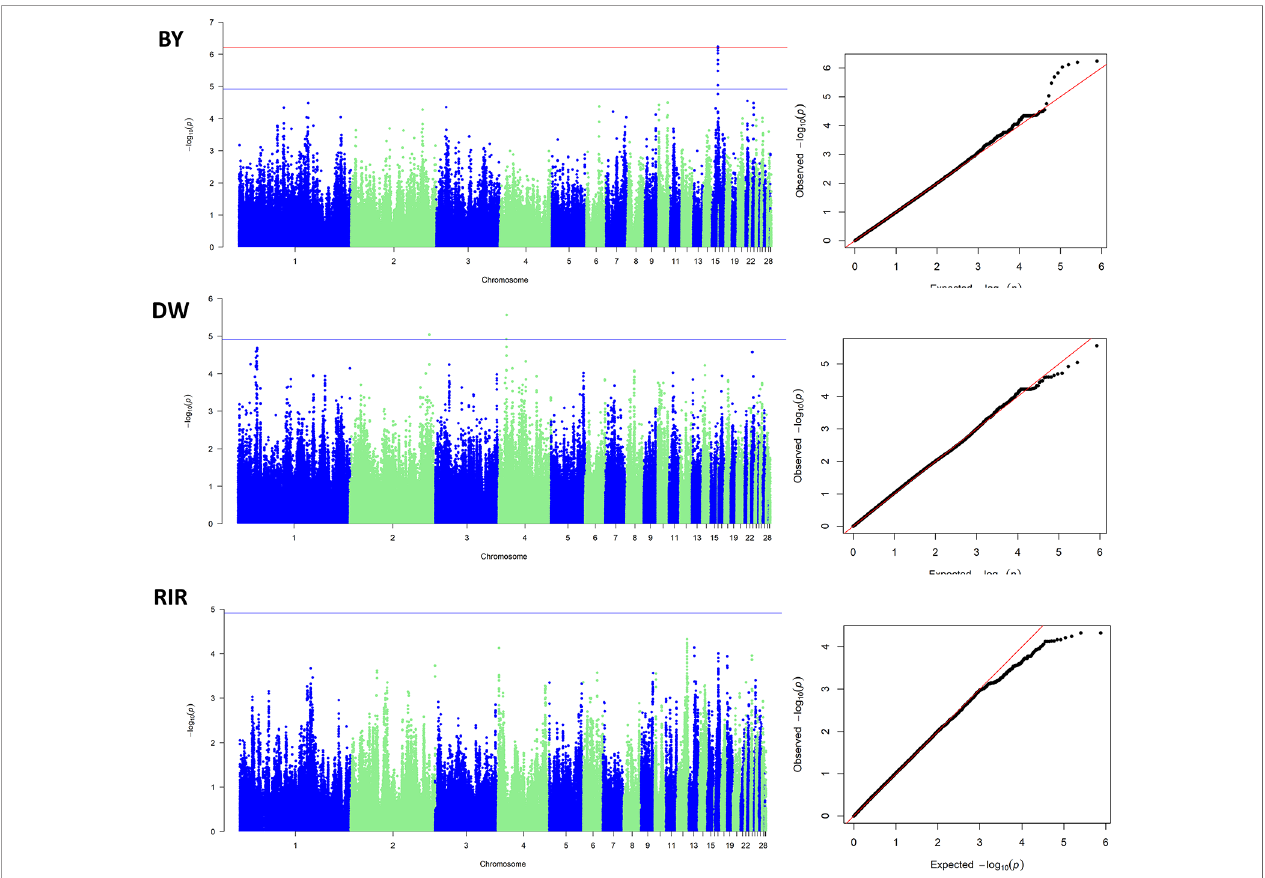
FIGURE 4 | Manhattan plots and Q-Q plots of GWAS